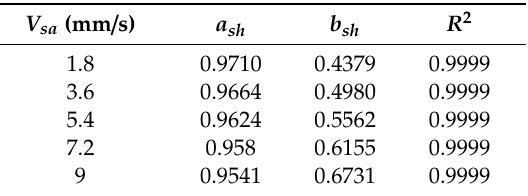
Table 5. The fitted coefficients of sample particle velocity V p versus sample flow velocity V sa at five different sheath flow velocities V sh .